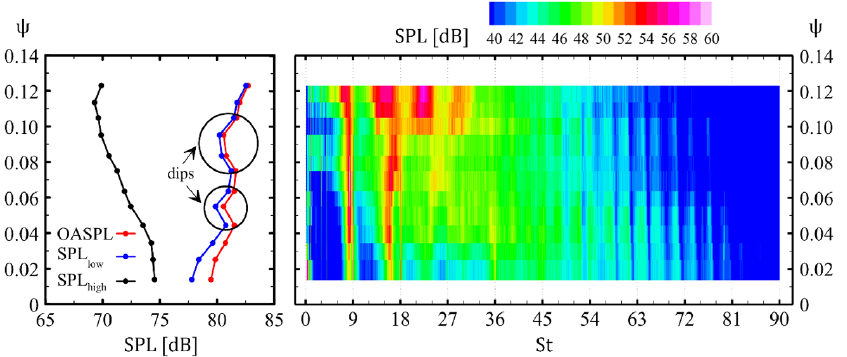
Figure 2. Dependence of the SPL on the operating conditions.